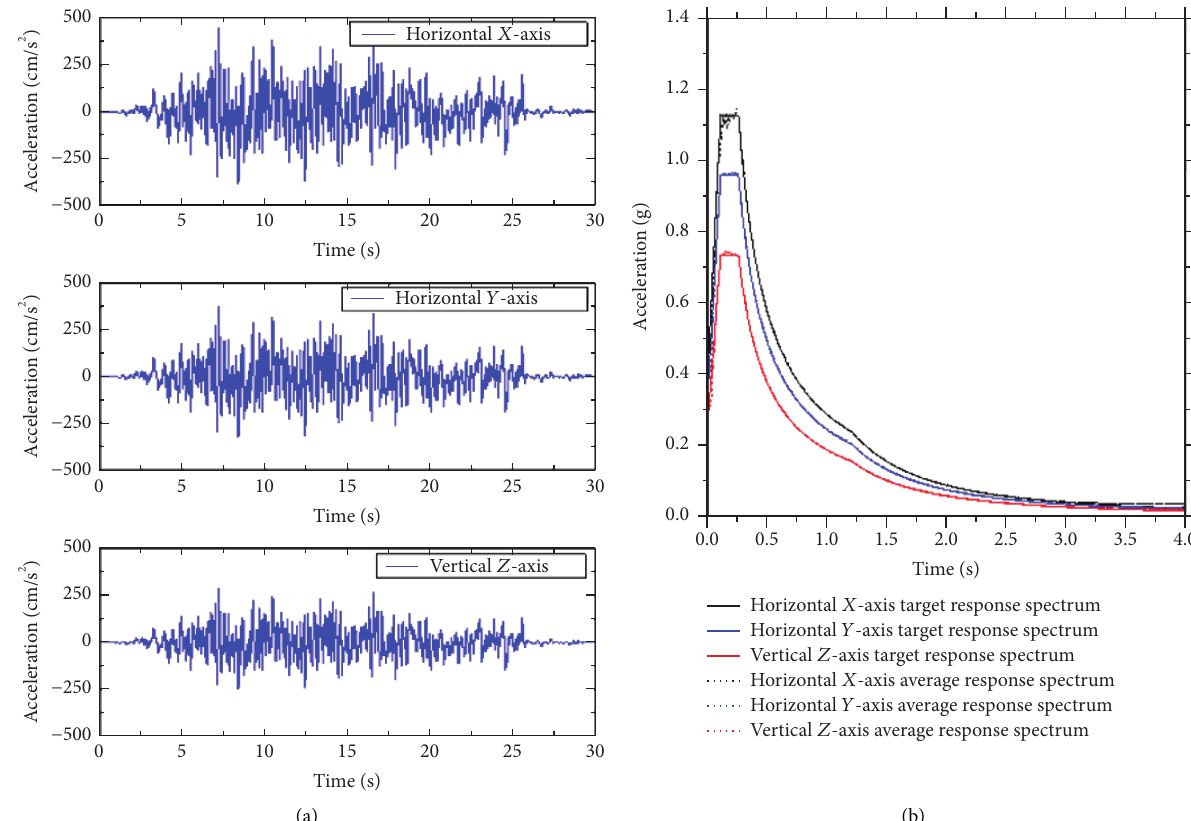
Figure 5: (a) Three-dimensional representative time history and (b) comparison with three-dimensional target response spectrum after